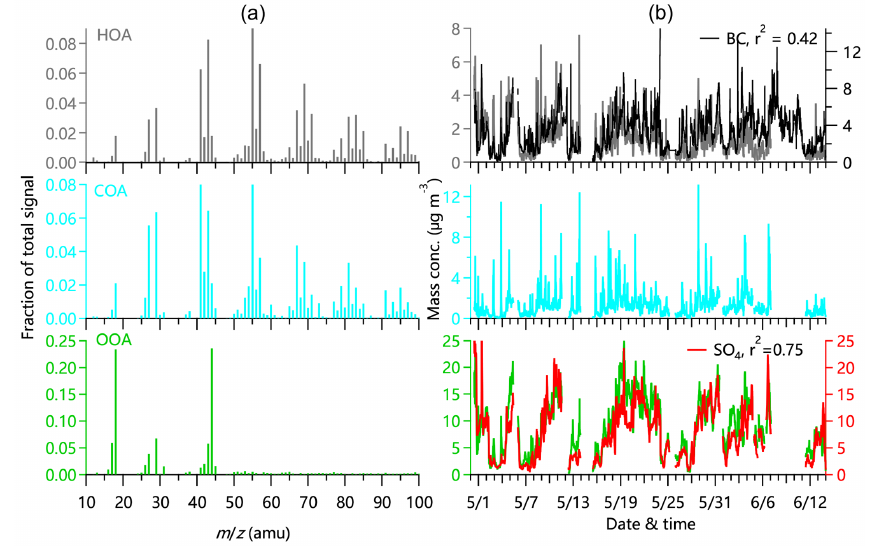
Figure 2. Mass spectral profiles (a) and time series of the mass concentrations of three OA factors (b) , i.e., HOA, COA, and OOA. Time series of the mass concentrations of BC and sulfate (right axis) are also